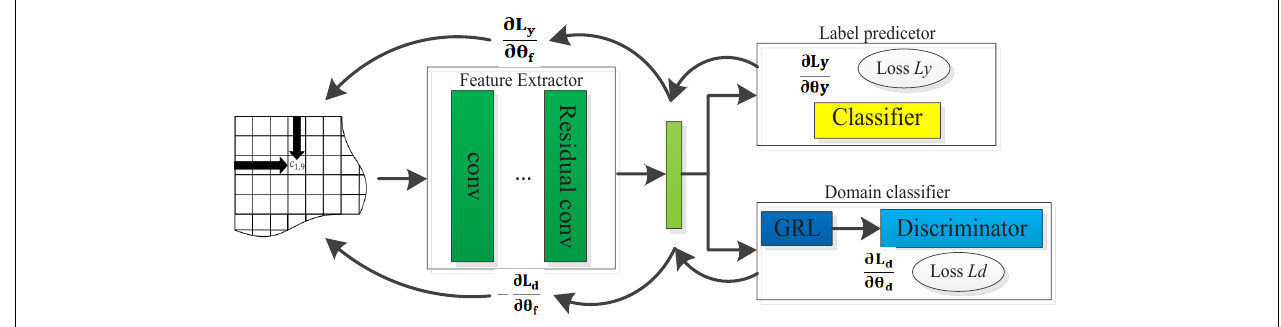
FIGURE 5 | Structure of the optimized DA-RCNN